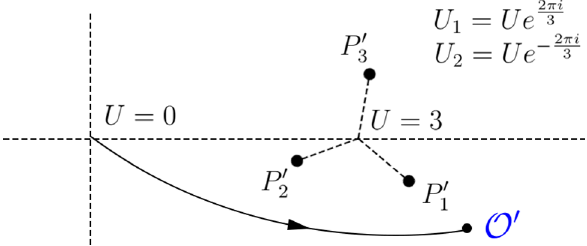
Figure 19 . The U -plane for SU(3) 2 theory and the path connecting the two observers O and O 0 probing the two holonomy